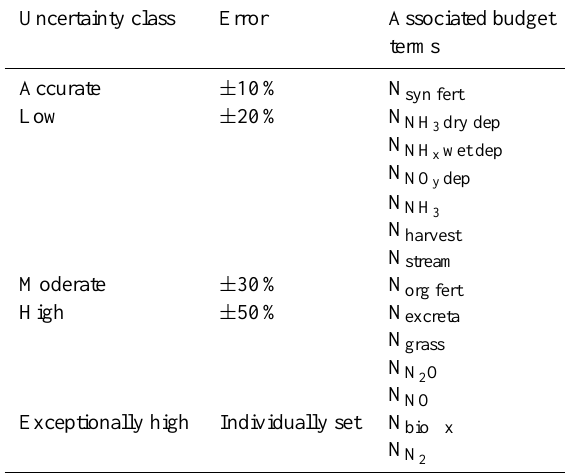
Table 1. Characteristics of the Moorland and the Grassland catch- ment.